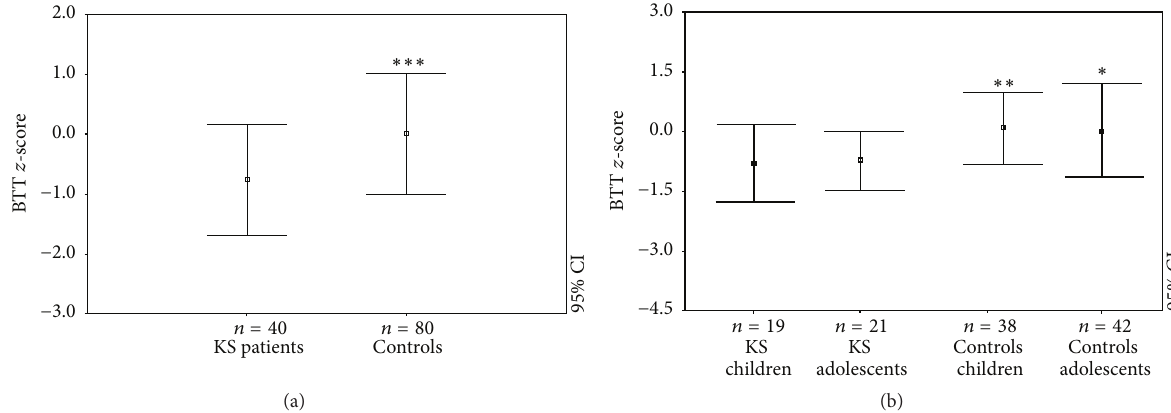
Figure 2: BTT z -scores in KS patients and controls (a) and in KS patients and controls when classified by age group (as children and adults) with the relative control groups (b). ∗ 𝑝 < 0.05 ; ∗∗ 𝑝 < 0.005 ; ∗∗∗ 𝑝 < 0.0005